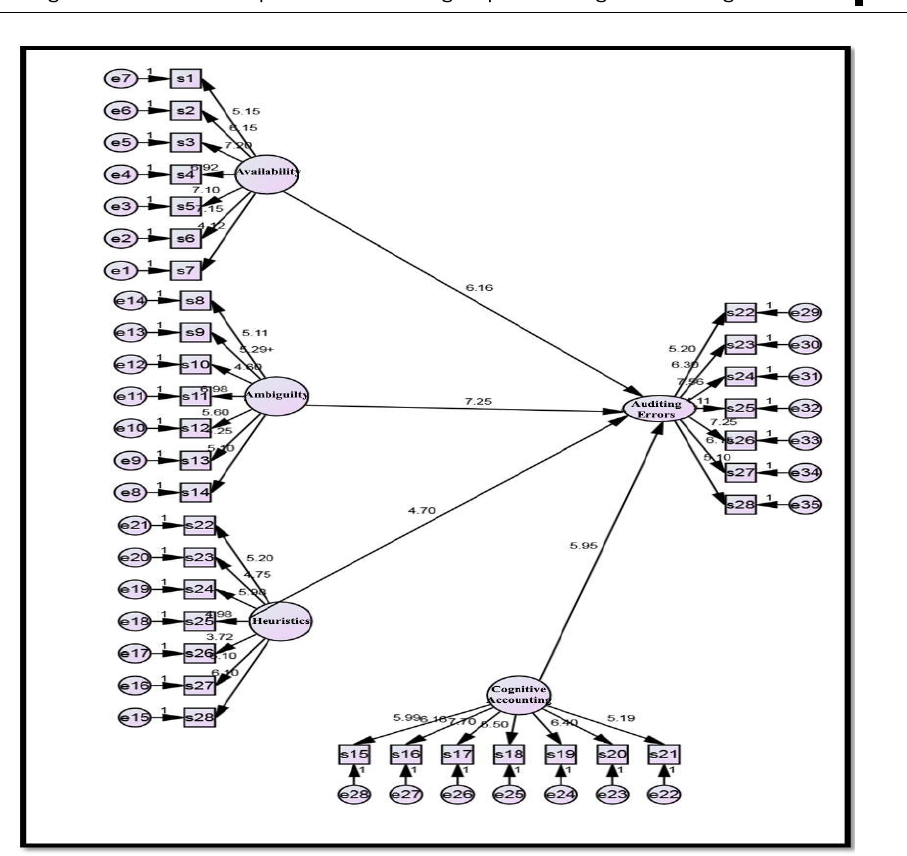
Figure (3) Structural equations Findings regarding the role of bias varieties on auditors’ errors based on significant